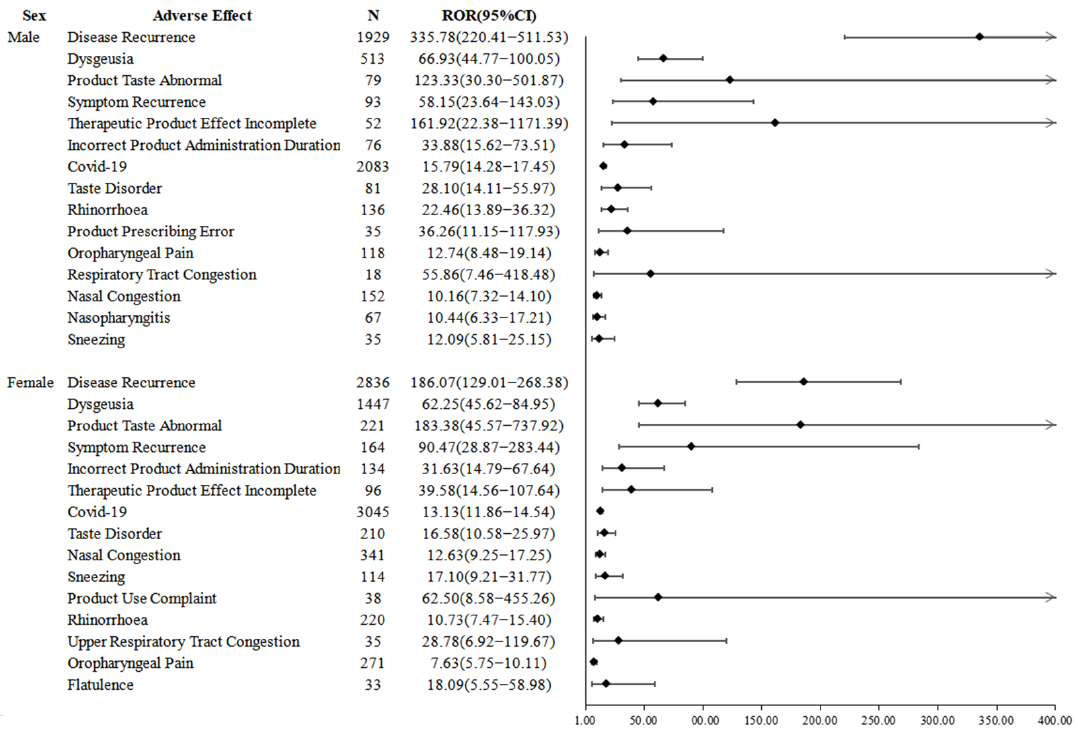
Figure 4. Signals of adverse events associated with nirmatrelvir/ritonavir use based on patient sex.